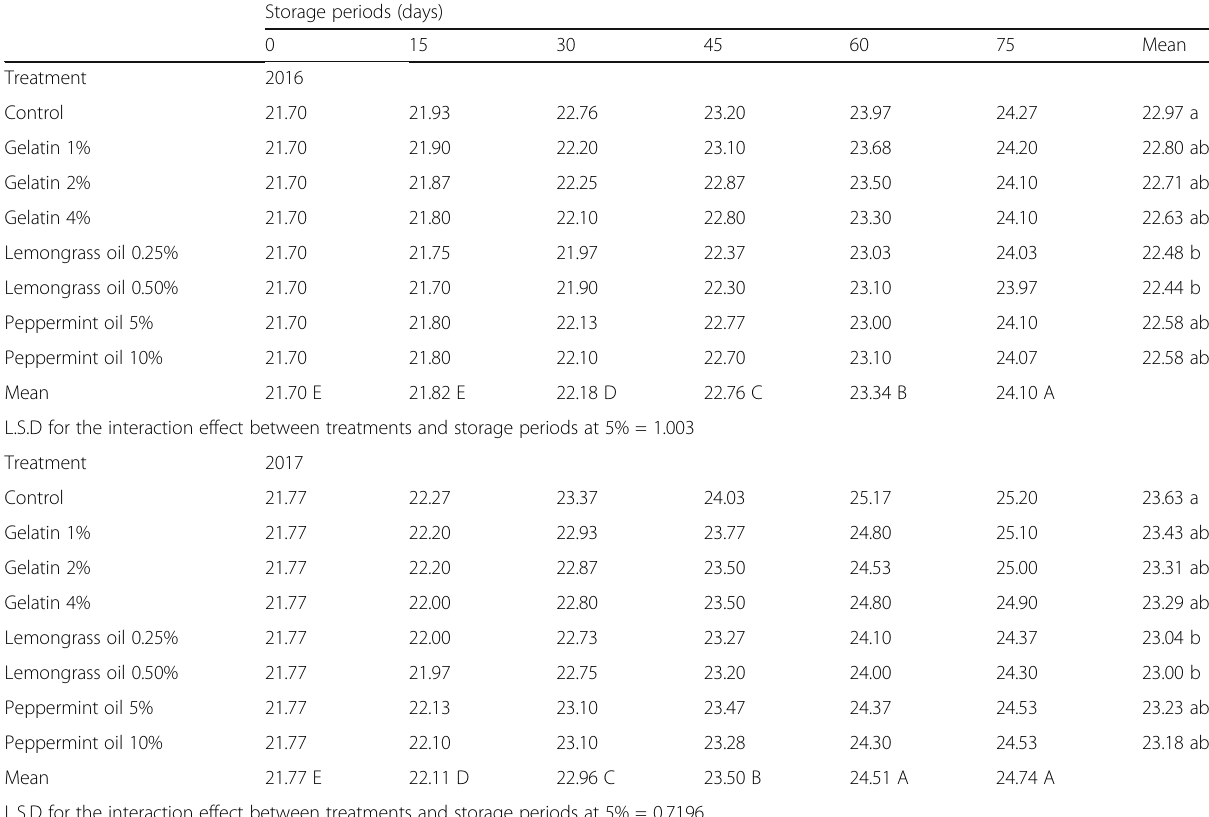
Table 4 Effect of gelatin, lemongrass oil and peppermint oil on the total soluble solid percentage (TSS %) of Samany date palm fruits stored at 0.0 °C ± 2 during two experimental seasons Storage periods